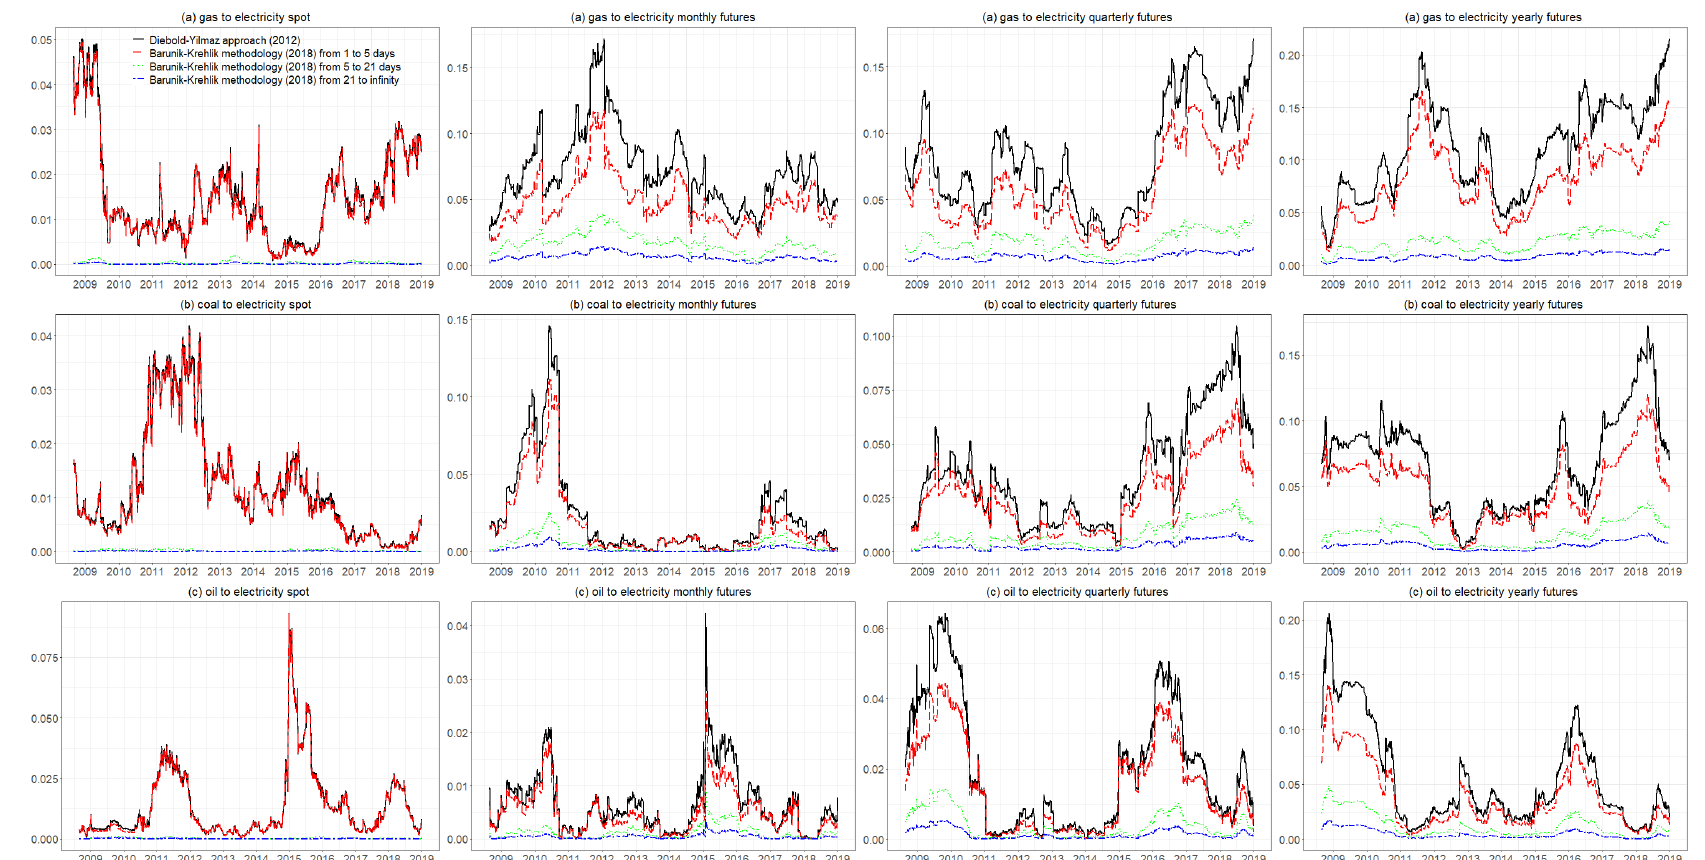
Figure A1. Diebold – Yilmaz approach (2012) directional return spillover (Pairwise) and Barunik – Krehlik methodology (2018) directional return spillover (Pairwise). Figure A1. Diebold–Yilmaz approach (2012) directional return spillover (Pairwise) and Barunik–Krehlik methodology (2018) directional return spillover